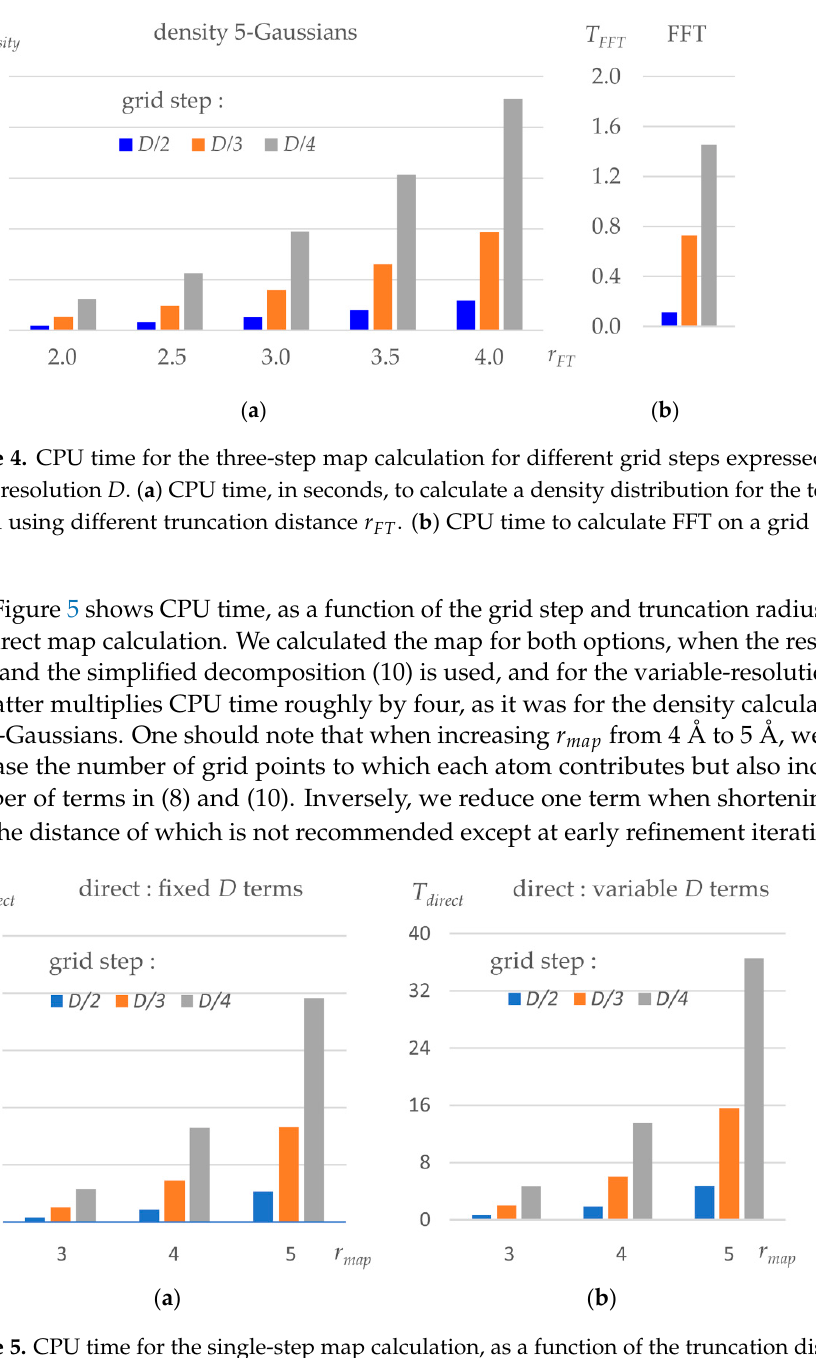
Figure 5. CPU time for the single-step map calculation, as a function of the truncation distance and the grid step, expressed as a part of the resolution D . ( a ) CPU time, in seconds, to calculate a density map for the test protein model using the simplified decomposition (10) of atomic images at a fixed resolution. ( b ) The same using the variable-resolution terms (8).